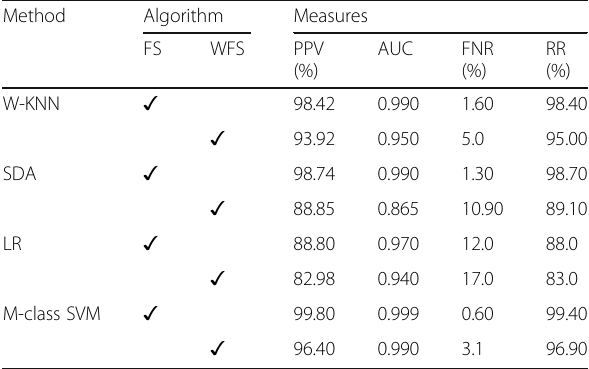
Table 12 Recognition results on Muhavi dataset